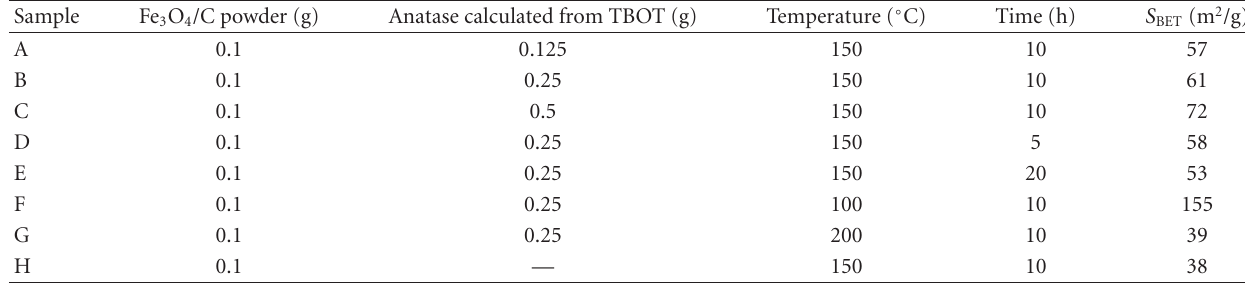
Table 1: Summary of the preparative parameters and the specific surface areas.